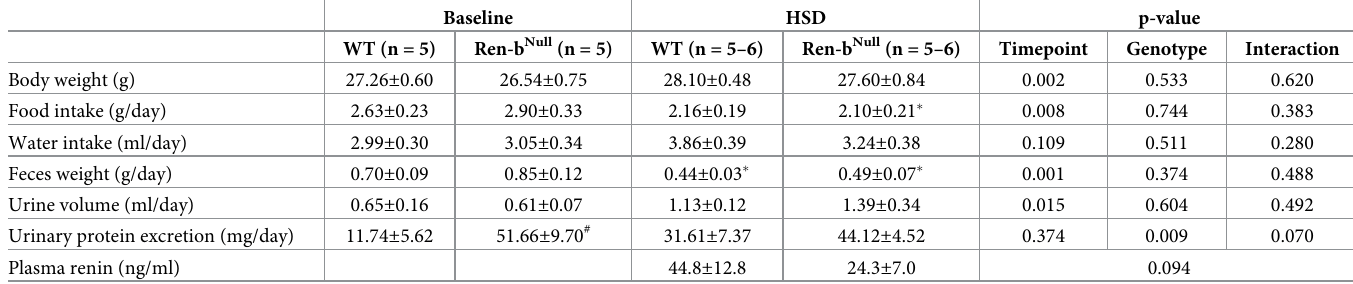
Table 1. Male Wildtype (WT) and Ren-b Null mice were housed in metabolic cages to measure food intake, feces weight, water intake, urine volume, and urinary pro- tein excretion at baseline and after 4 weeks on high salt diet (HSD, 4% NaCl).